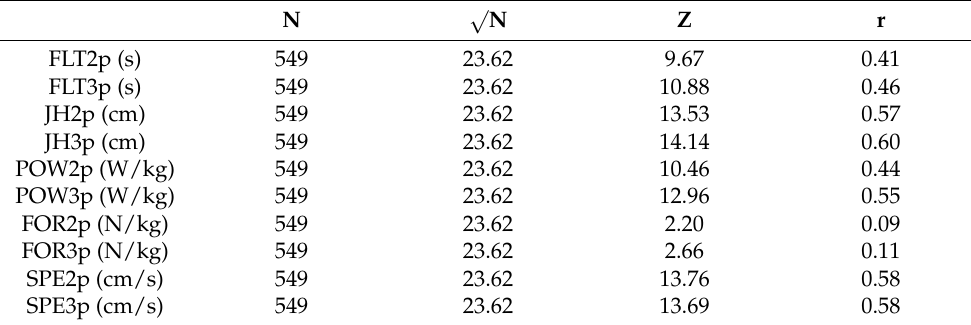
Table 3. Influence of specific training program in the experimental group